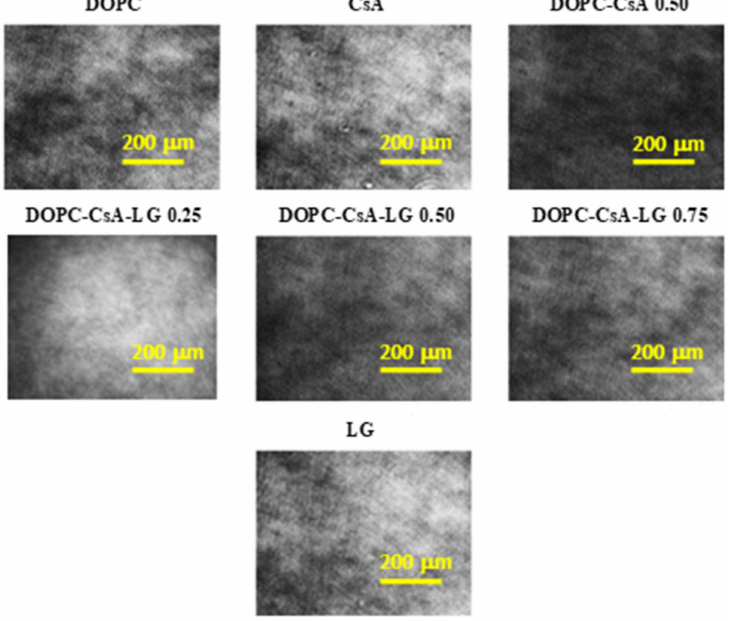
Figure 2. BAM images taken for the single (DOPC, CsA, LG), binary (DOPC-CsA 0.50), and ternary (DOPC-CsA-LG 0.25, 0.50, 0.75) monolayers at 10 mN m − 1 on the water